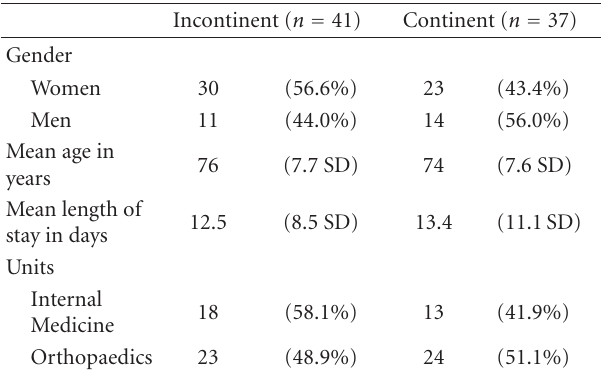
Table 1: Patients’